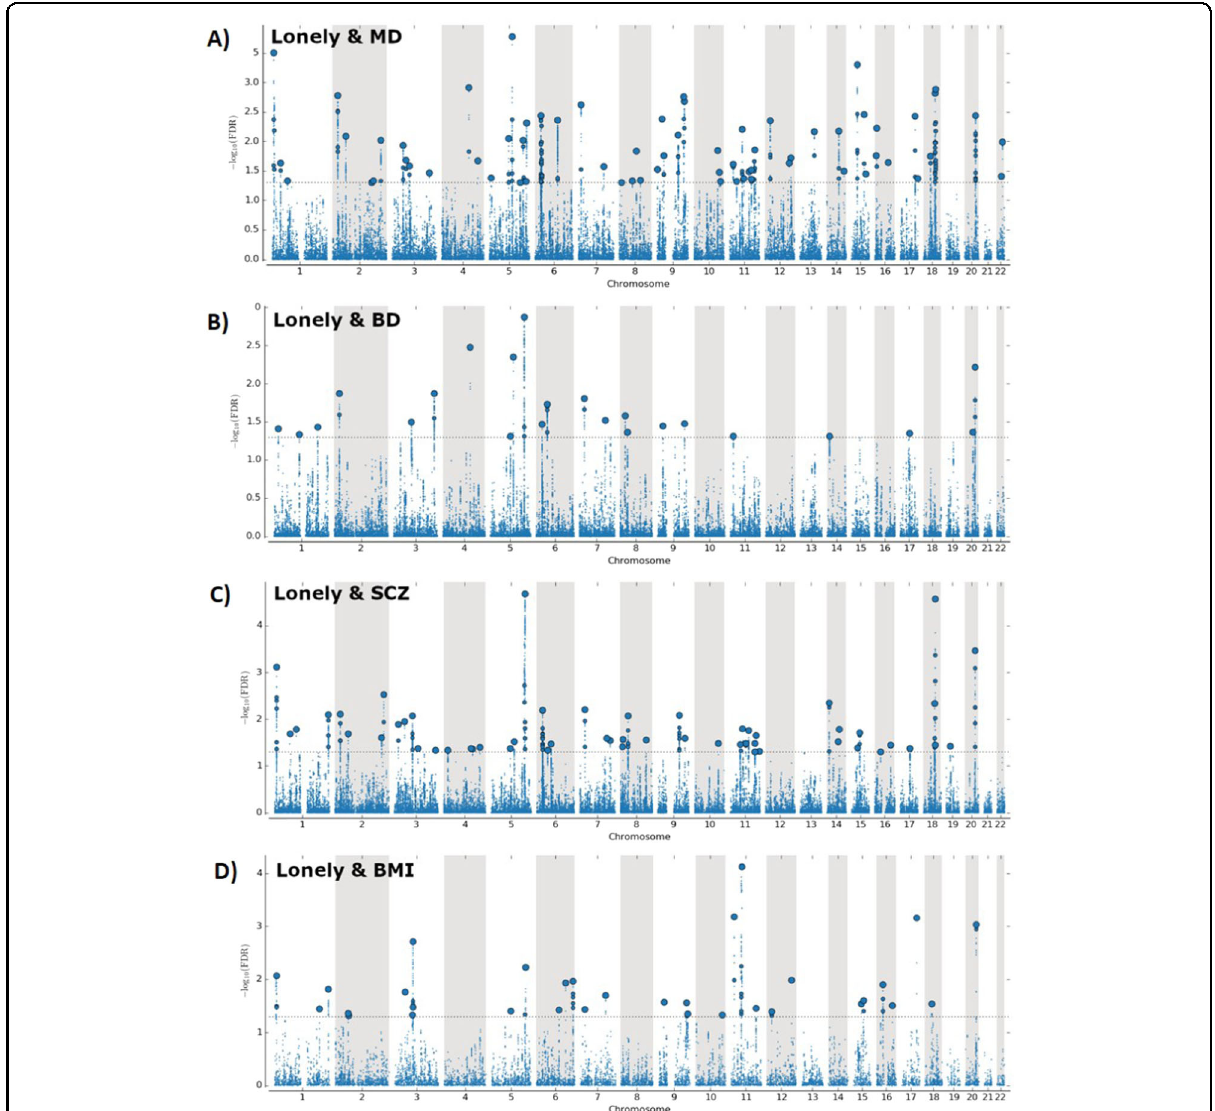
Fig. 2 Common genetic variants jointly associated with loneliness and MD, BD, SCZ, and BMI at conjFDR <0.05. Manhattan plots for loneliness and A ) major depression, B ) bipolar disorder, C ) schizophrenia and D ) body mass index. Manhattan plots showing the − log10 transformed conjFDR values for each SNP on the y axis and chromosomal positions along the x axis. SNPs with conjunction FDR < 0.05 (i.e., − log10 FDR > 1.3) are shown with enlarged data points. A black circle around the enlarged data points indicates the most signi fi cant SNP in each LD block. The fi gure shows the localization of the “ conjunctional loci ” , and further details are provided in Supplementary Tables 17 – 20. MD major depression, SCZ schizophrenia, BD bipolar disorder, BMI body mass index, conjFDR conjunctional